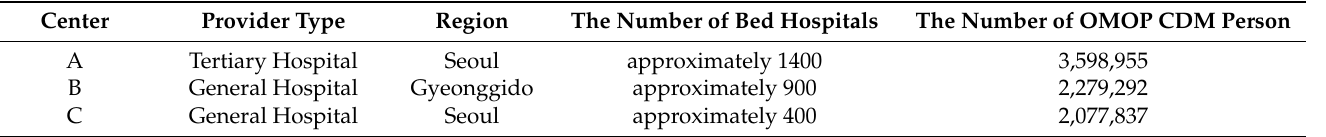
Table 3. Characteristics of A, B, C